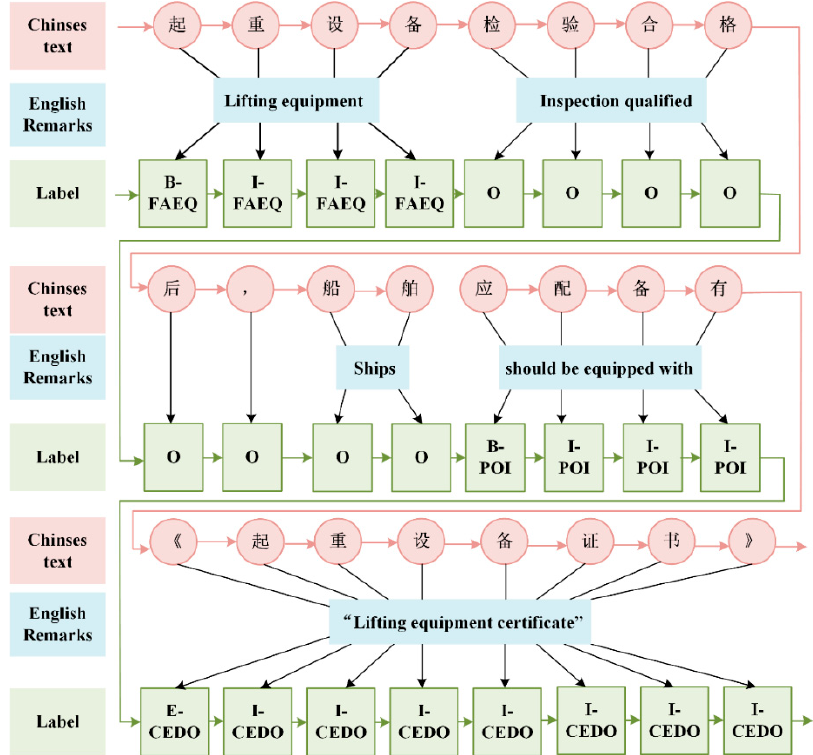
Figure 5. Sequence labeling example for the FSC inspection. The "Chinese text" part refers to the specific content of the obtained text data, which means “after the inspection of lifting equipment is qualified, ships should be equipped with the relevant ‘lifting equipment certificate’”.